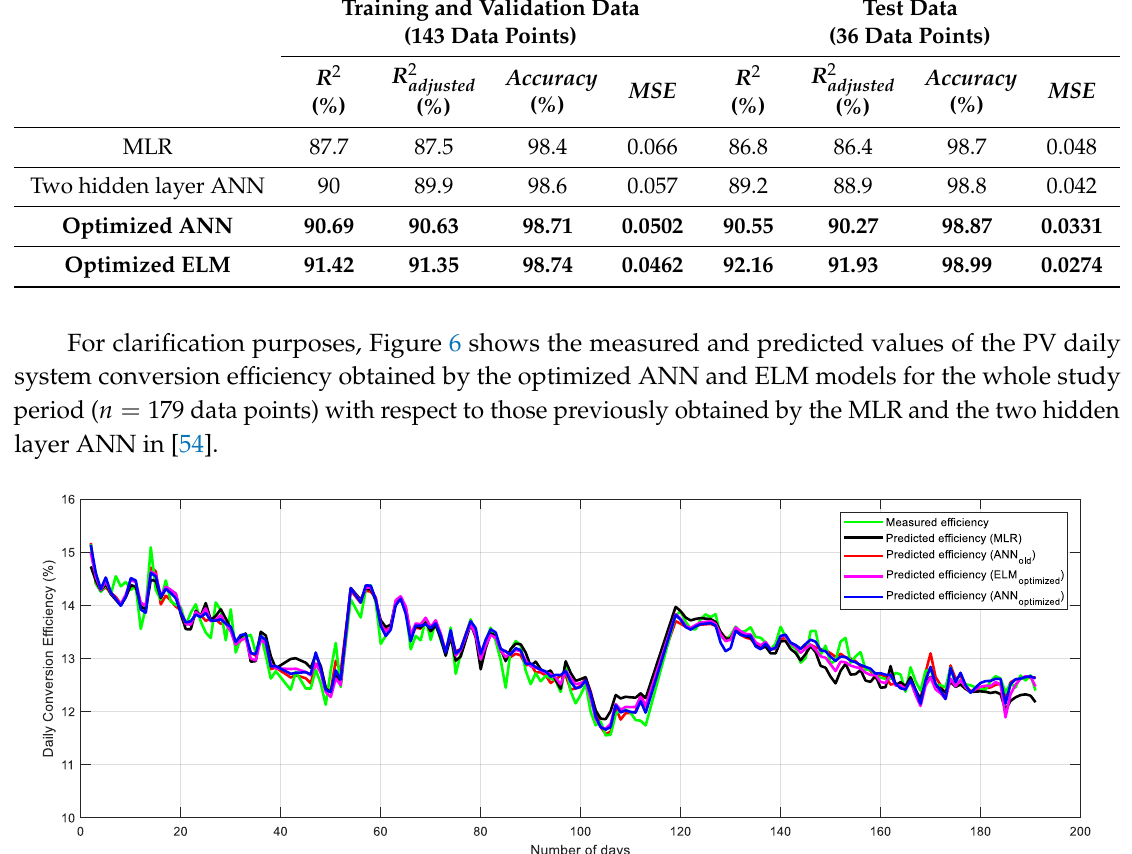
Figure 6. Measured and predicted values of the PV daily system conversion efficiency obtained by the prediction models for the whole study period.